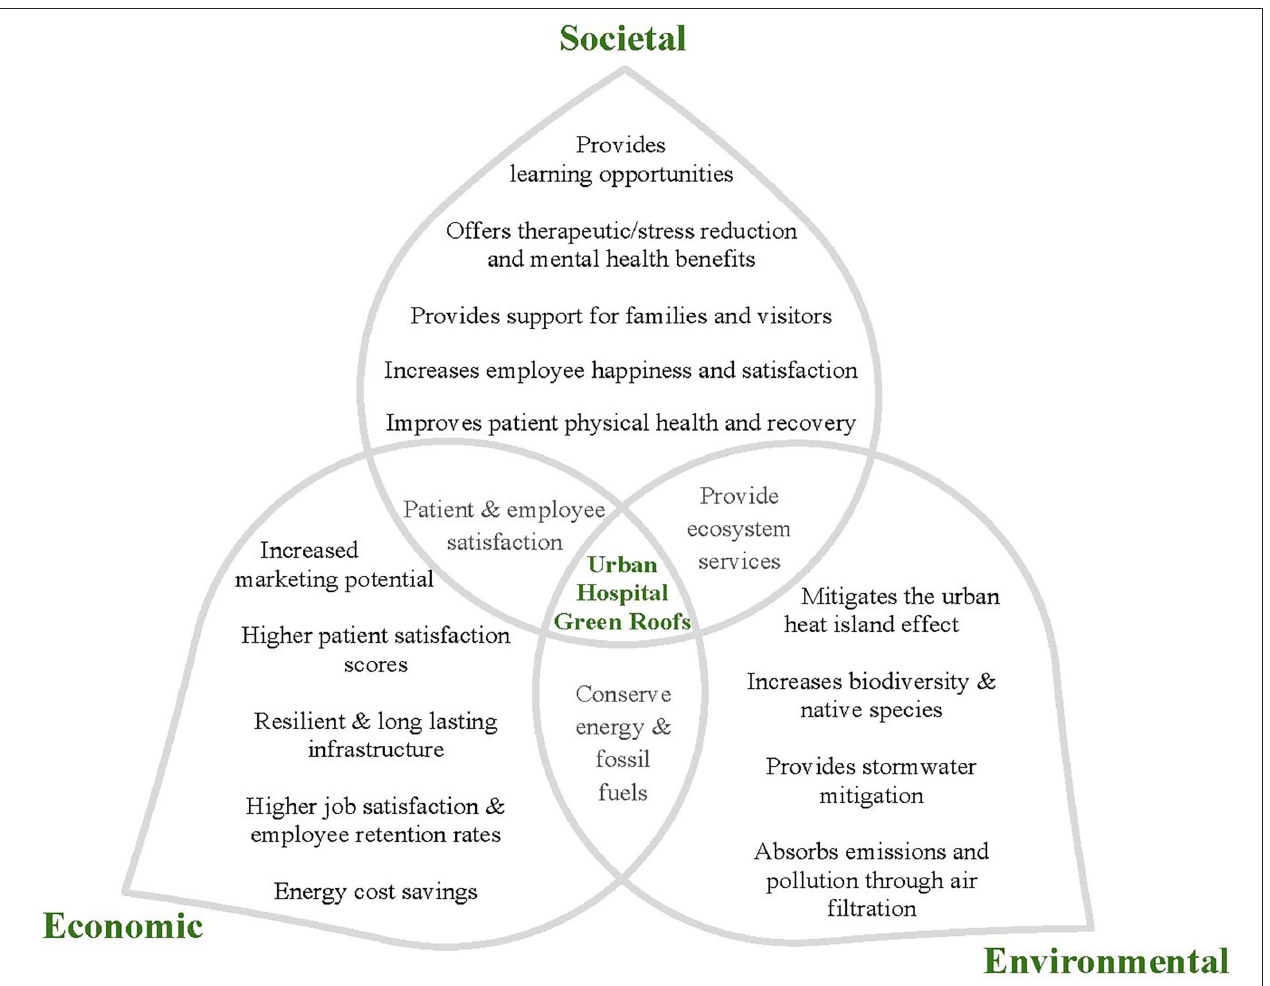
FIGURE 7 | Benefit summary of green roofs on hospitals based on the three pillars of